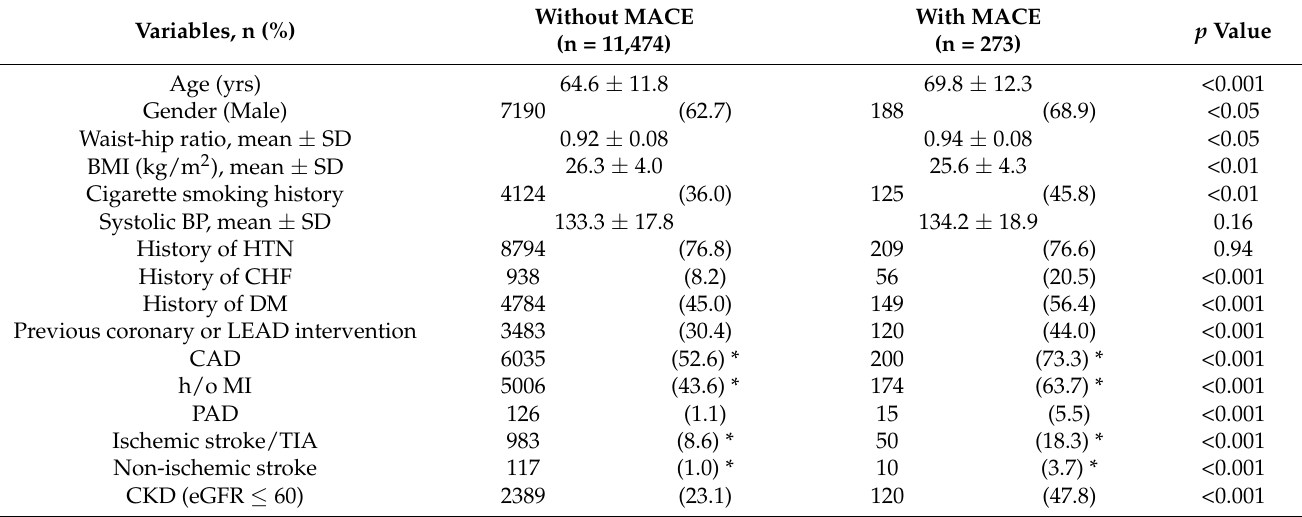
Table 1. Baseline characteristics of all patients by primary outcome